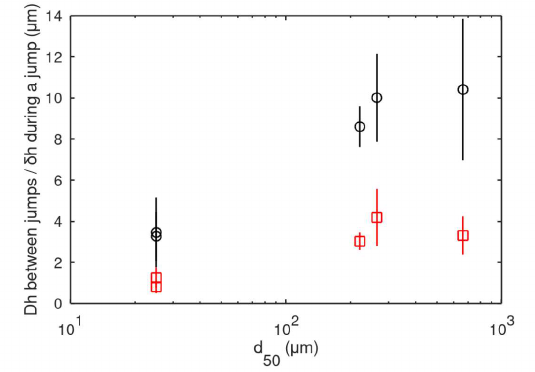
Fig. 4. Bed deformation between two fast relaxation events Dh (black circles), and bed deformation during a fast relaxation event δh (red squares) versus the median particle diameter, with associated standard